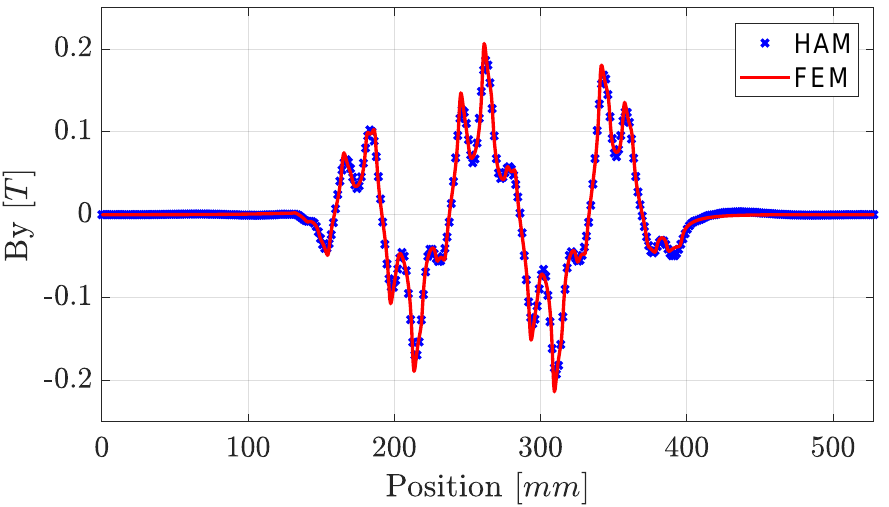
Figure 7. Magnetic flux density in longitudinal direction in the middle of the air gap ( I p = 10 A, v = 0 m/s, f = 100